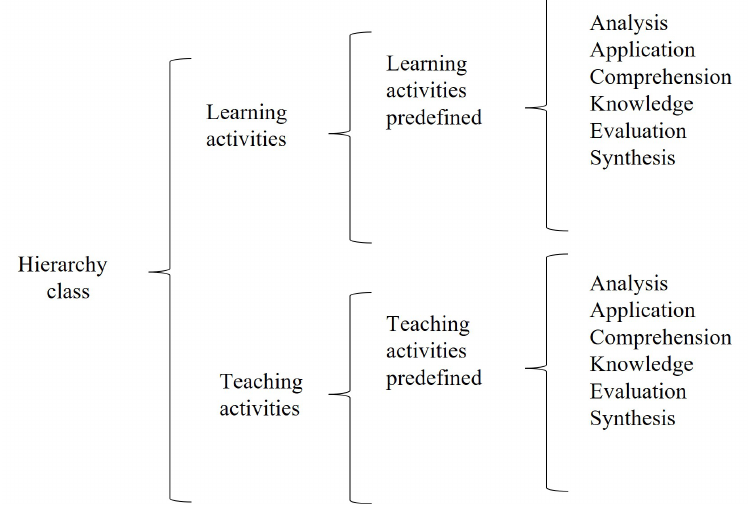
Figure 3. Hierarchical view of concepts “learning and teaching